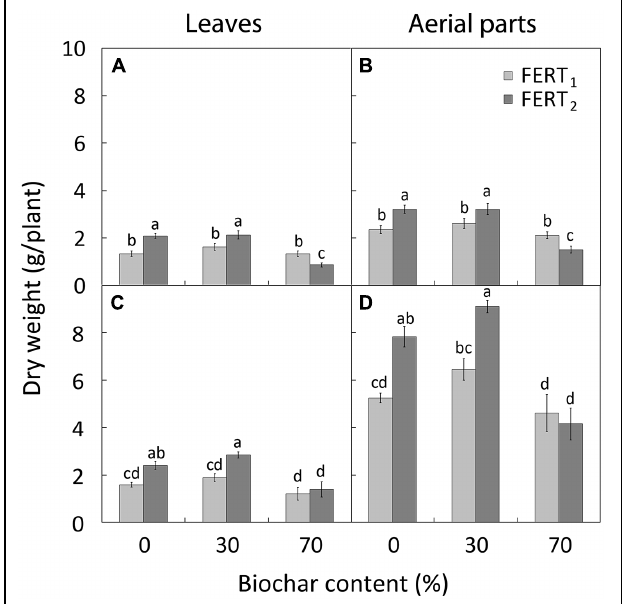
FIGURE 2 | Effect of peat:biochar ratio and fertilization rate on leaf and total DW of Pelargonium plants at mid-season (28 DAT; A and B, respectively) and at the end of the cycle (C and D, respectively). Bars indicate SEs ( n = 8). Treatments with different letters are significantly different according to the LSD test ( P = 0.05).